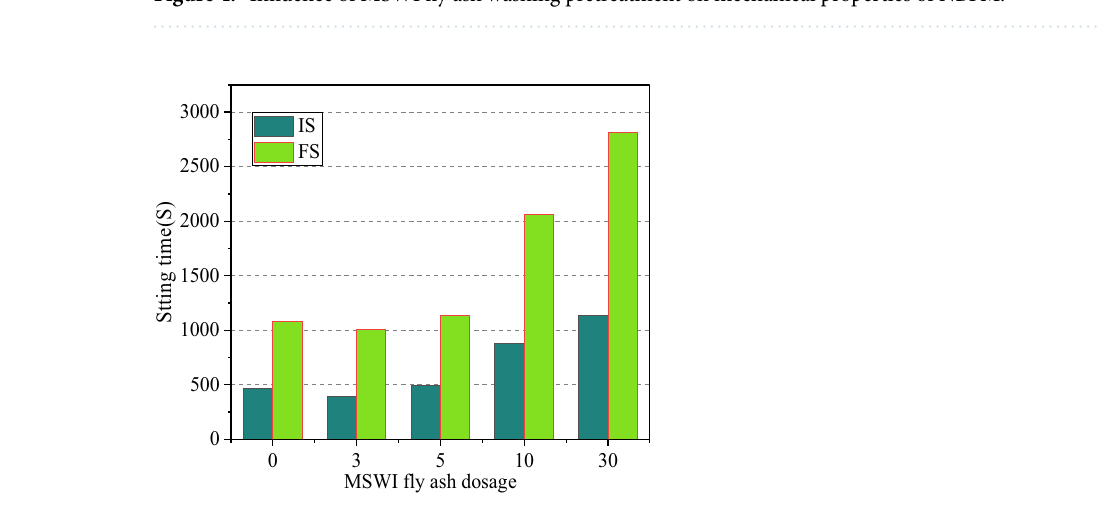
Figure 4. Influence of MSWI fly ash washing pretreatment on mechanical properties of NBFM.